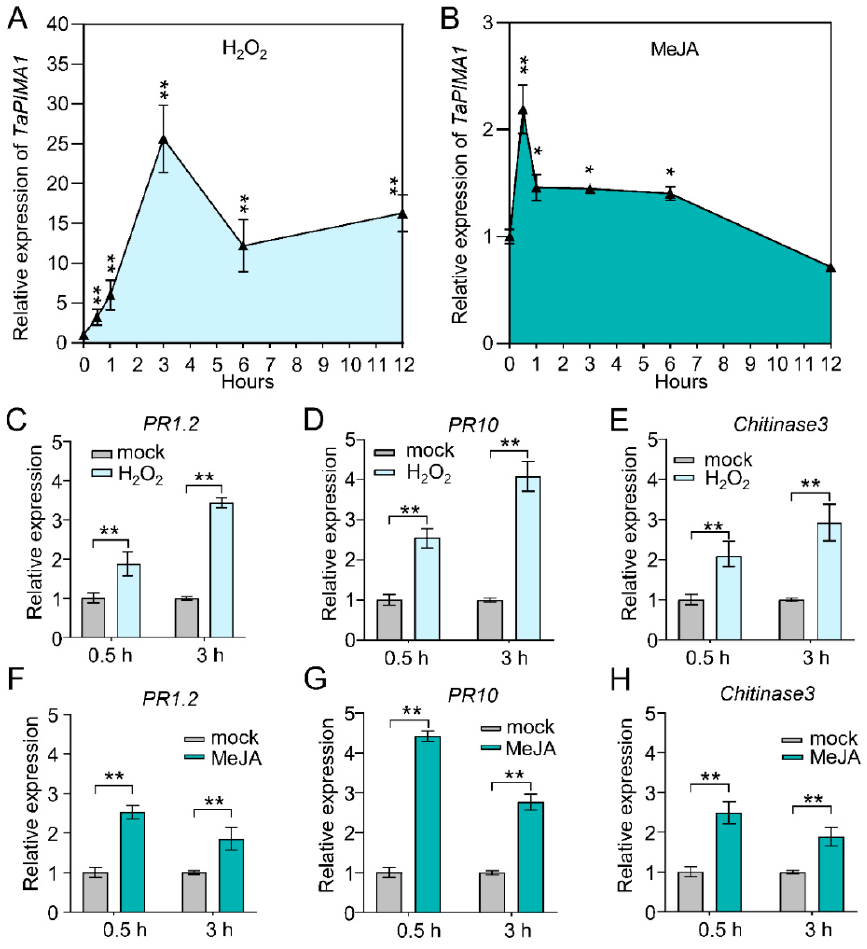
Figure 6. The expression profiles of TaPIMA1 and PR genes in H 2 O 2 /MeJA-treated CI12633 plants. The expression profiles of TaPIMA1 in CI12633 plants after exogenous application of H 2 O 2 ( A ) and MeJA ( B ). Expression of PR1.2 , PR10 , and Chitinase3 in H 2 O 2 ( C – E )- and MeJA ( F – H )-treated CI12633 wheat plants. The CI12633 plants were sprayed with 10 mM H 2 O 2 /0.1 mM MeJA and 0.1% Tween-20 (mock) at the four-leaf stage, respectively. The significant differences were determined by Student’s t -test (* p < 0.05, ** p < 0.01). Error bars indicate standard deviation. TaActin was used as internal control.